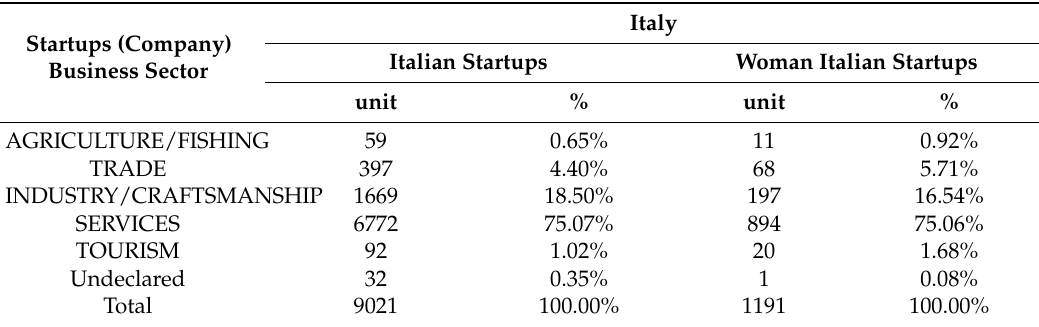
Table 9. Business sector of Italian startups and Italian woman